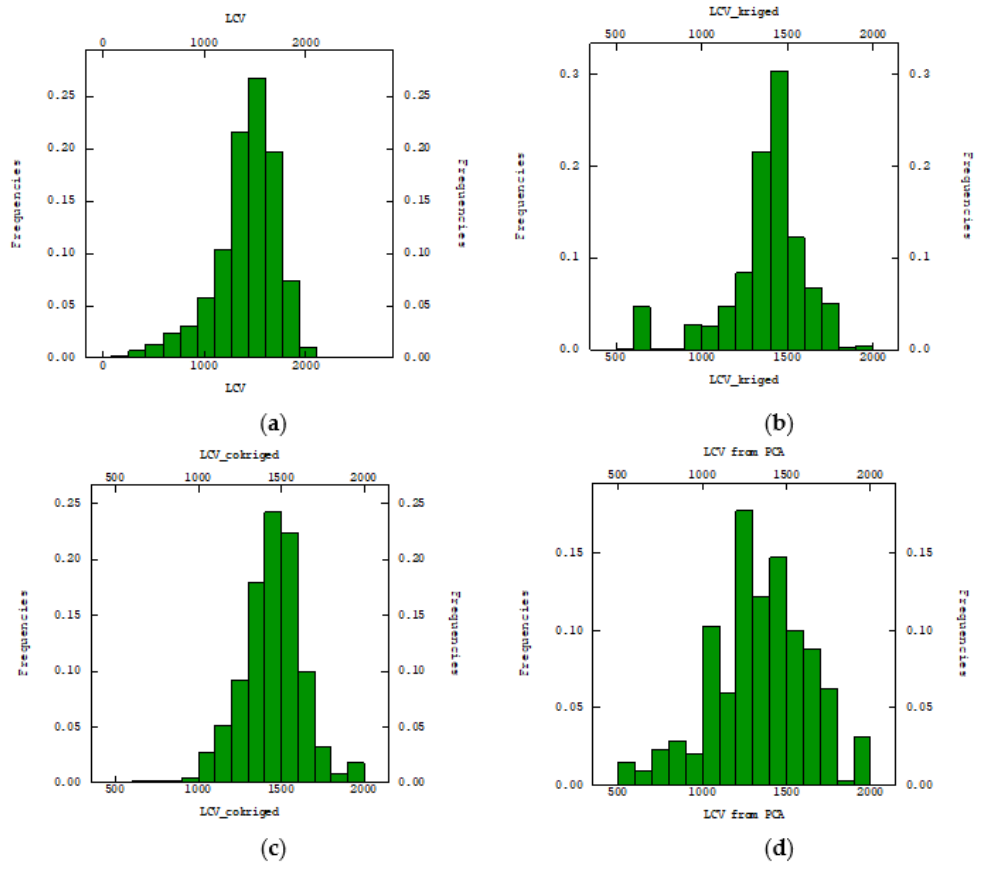
Figure 19. Statistical distributions of LCV from ( a ) samples, ( b ) kriging, ( c ) cokriging, and ( d ) PCA.